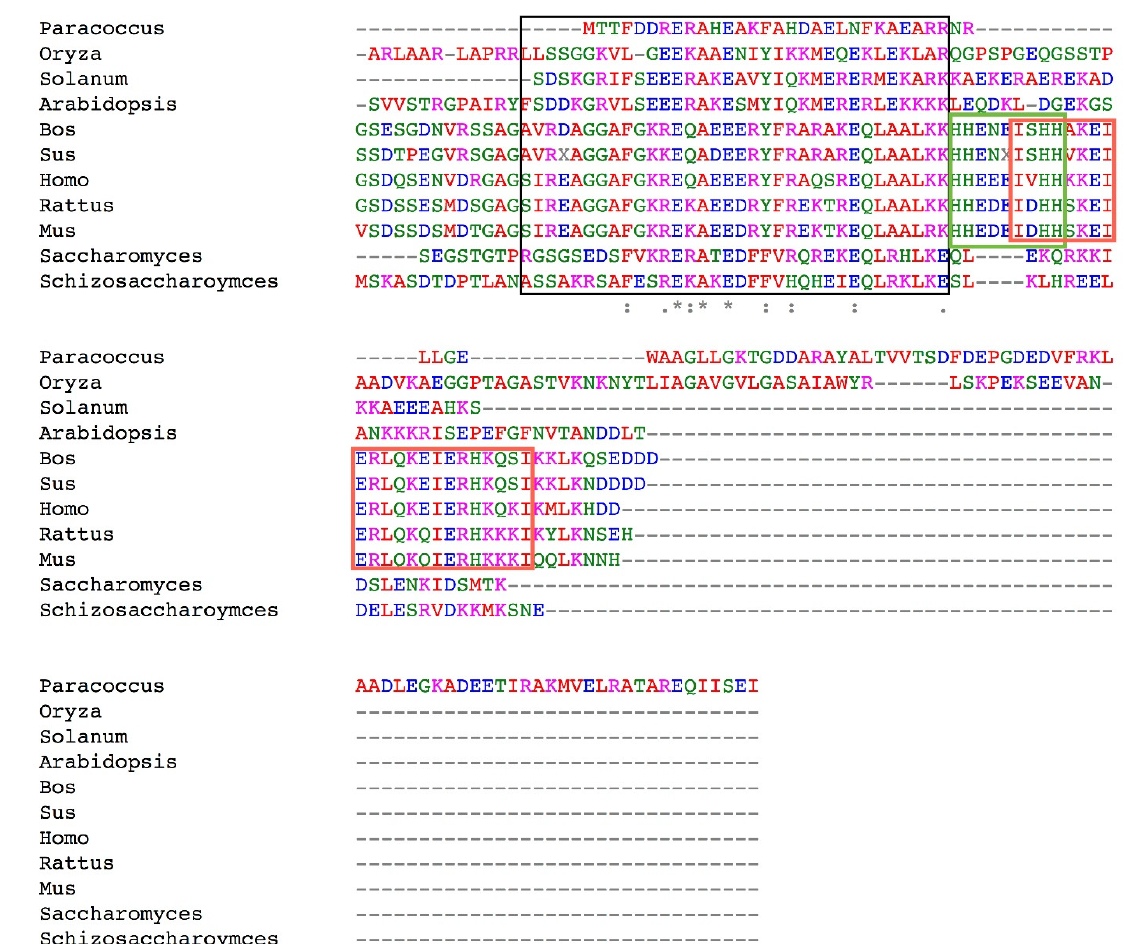
Figure 5. Alignment of the ζ subunit of P. denitrificans (Pd- ζ ) with the inhibitory mitochondrial IF 1 protein family. The full sequence of Pd- ζ was aligned with representative sequences of mito- chondrial IF 1 inhibitor proteins from yeast, animals, and plants. The IF 1 sequences correspond to the mature proteins, with the first residue starting to alter removal of the mitochondrial targeting sequences (MTSs). The region boxed in black ( ) corresponds to the N-terminal part of the minimal inhibitory sequence of IF 1 as defined by biochemical [91] and genetic deletion analyses [92] and by direct observation of contact residues between IF 1 and the F 1 -ATPase in crystal structures [93]. (*) indicates identical residues, (:) show very similar residues, and (.) indicates similar residues. Blank marks ( ) show variable residues following Clustal- Ω alignments. The green box indicates the segment containing the pH sensor of His pairs in animal IF 1 s ( ). The red-orange box ( ) shows the homodimerization domain of animal IF 1 s with the Ile heptads in the C-termini that promotes IF 1 -IF 1 and F 1 F O -F 1 F O dimerization, tetramerization, further mtATP synthase oligomerization, and mitochondrial cristae formation (see text and Figures 6 and 7). We previously presented a simpler version of this alignment [29]. Aligned species are Paracoccus denitrificans , representing the ζ subunit, and the rest of the sequences correspond to mature mitochondrial IF 1 s: Oryza sativa , Solanum tuberosum , Arabidopsis thaliana , Bos taurus , Sus scrofa , Homo sapiens , Rattus norvegicus , Mus musculus , Saccharomyces cerevisae , and Schizosaccharoymyces pombe . See text for further details. pendently as analogous rather than homologous proteins.